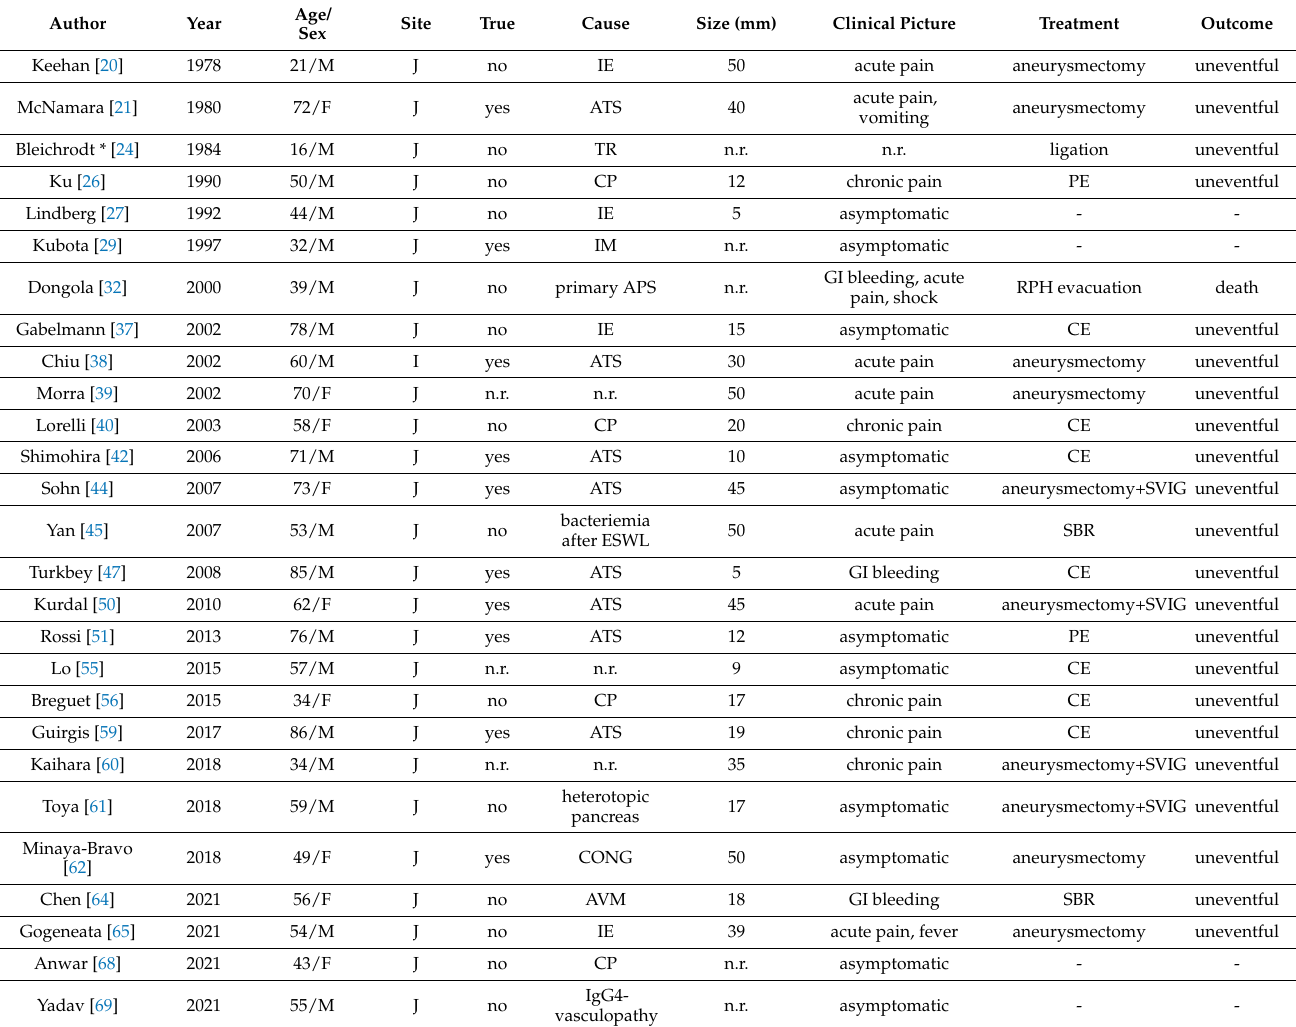
Table 3. Single case reports of non-ruptured JA and IA